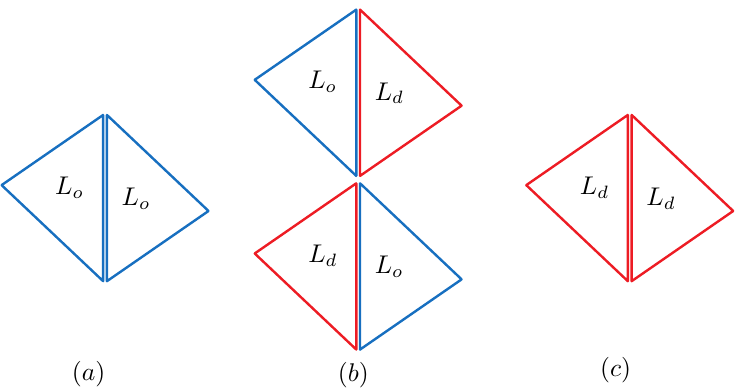
Figure 1. The dependence of κ ij and γ ij on four possible combinations of L o and L d : ( a ) κ ij = γ ij = ( c + c − 1 ) /2 on ( L o , L o ) ; ( b ) κ ij = γ ij = ( 2 + c + c − 1 ) /4 on ( L o , L d ) ; and ( c ) κ ij = γ ij = 1 on ( L d , L d ) . ( L o , d , L o , d ) correspond to the bonds represented by the duplicated lines.